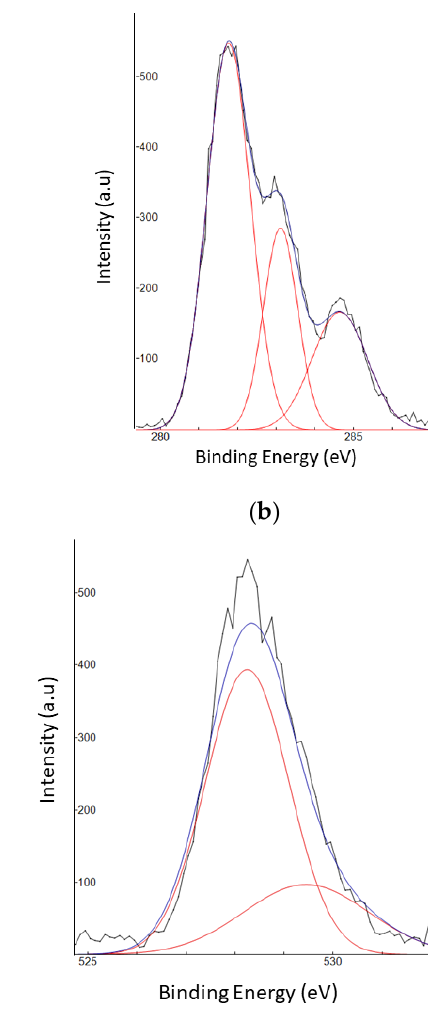
( b ) Figure 4. ( a ) Infrared spectra of a bare CQD. ( b ) Decay curve of a CQD and a CQD-chlorophyll. XPS measurements were carried out to investigate the details of CQD composition. As shown in Figure 5a, the survey spectrum discloses three prominent peaks: C1s at 284 eV, N1s at 396 eV, and O1s at 528 eV. Thus, the CQD is composed of C, N, and O compo-